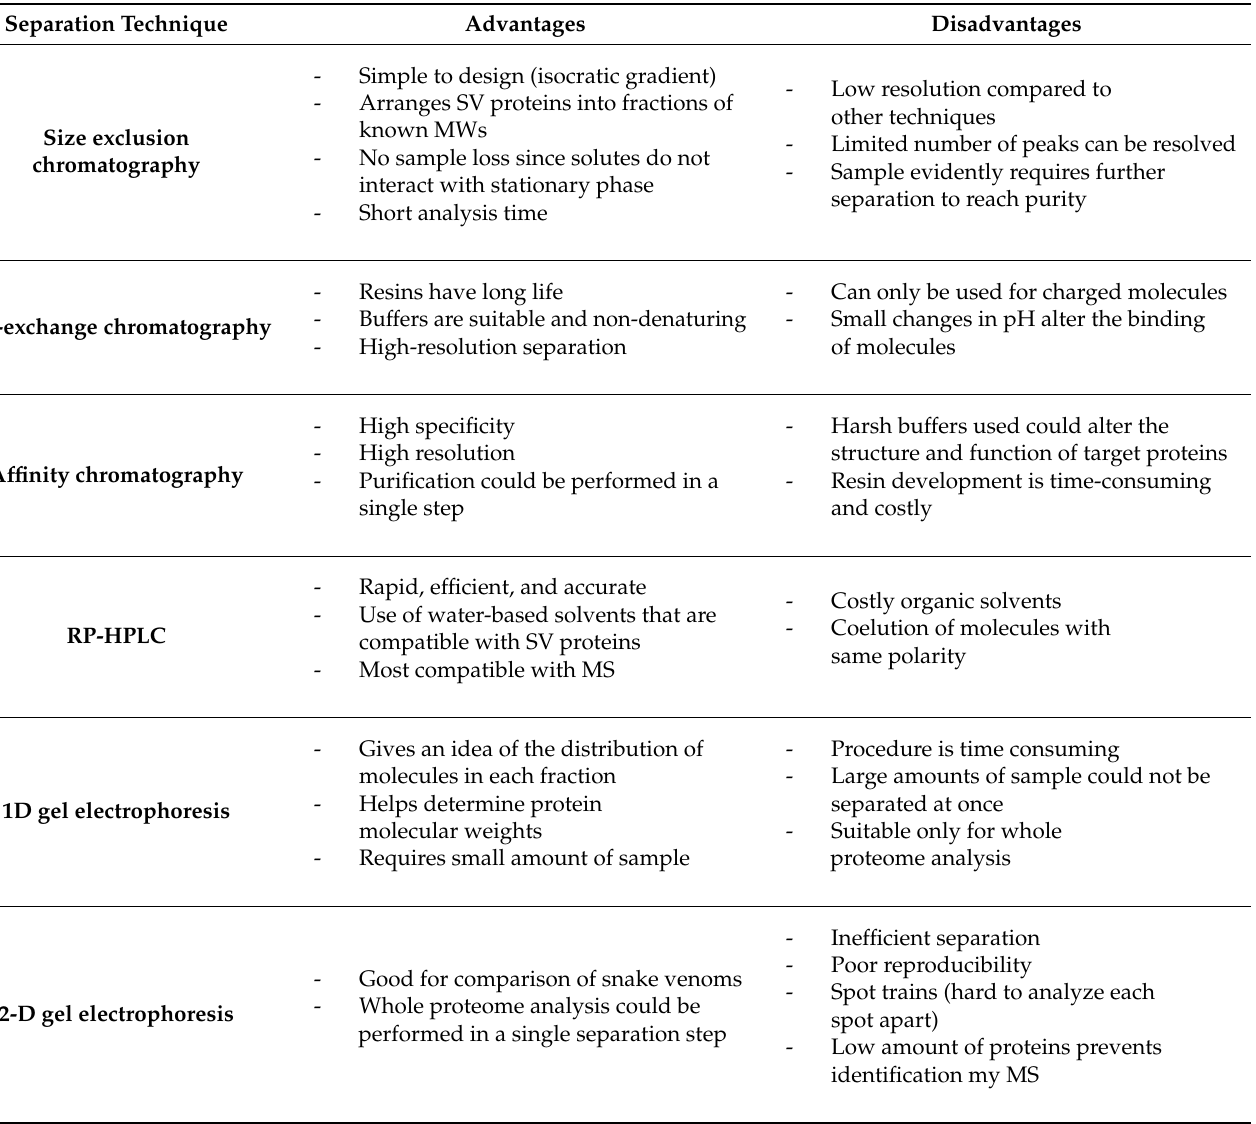
Table 1. The advantages and disadvantages of different separation techniques used for snake venom